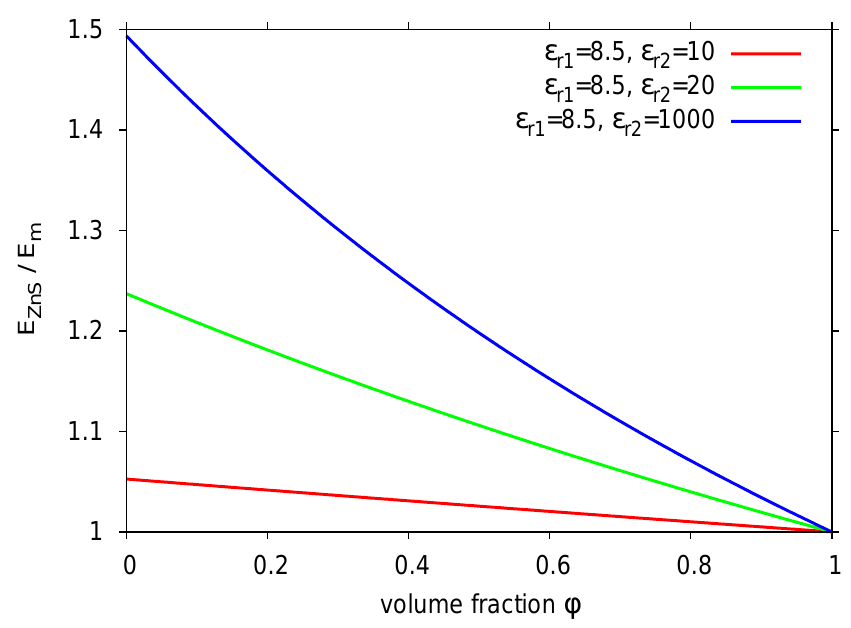
Figure 4 . Electric field strength over luminescent